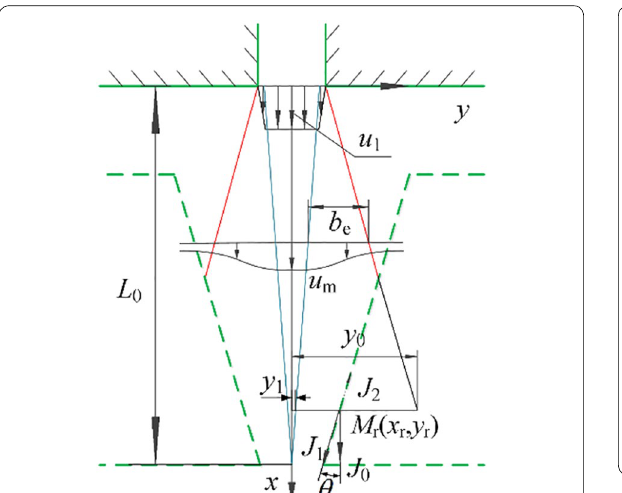
Figure 21 Longer core area assumption